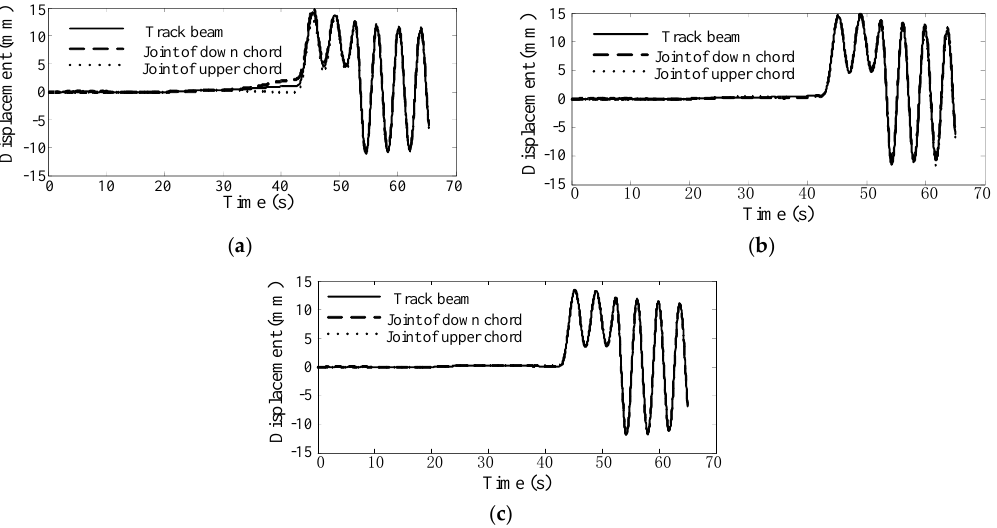
Figure 13. The time – history curves of the longitudinal displacements with the train braking in the mid-span of the bridge at a speed of 40 km/h: ( a ) the middle of the main span ; ( b ) the quarter position of the main span; ( c ) the middle of the Y-shaped rigid frame.